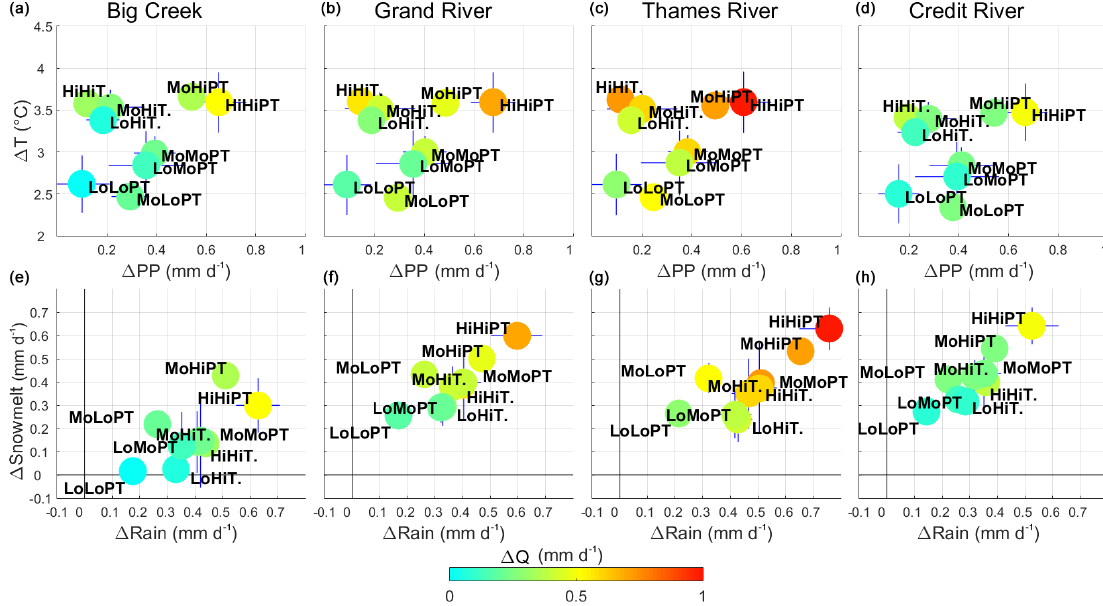
Figure 7. Change of streamflow (colors) with respect to changes of daily temperature and precipitation amount (a–d) and snowmelt and rain amounts (e–h) between the historical and the 2040s periods in January–February.